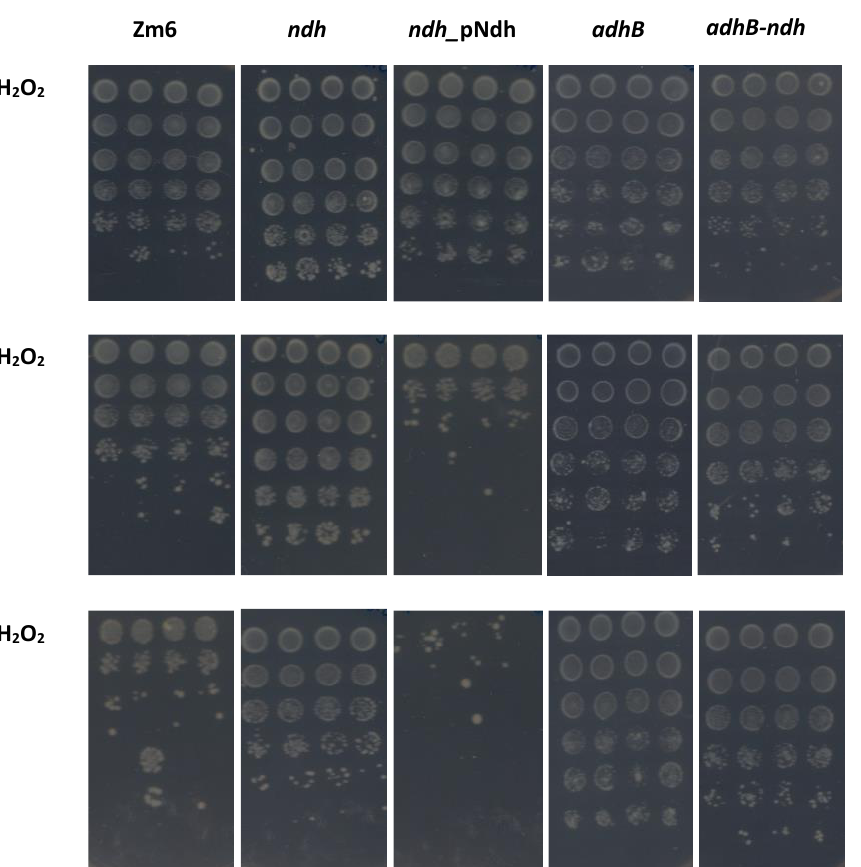
Figure 3. Viability of cells from exponential phase cultures after 30 min incubation with hydrogen peroxide. Serial dilutions ranging from OD 0.5 to 0.5 × 10 − 5 (from the top to bottom of each panel) were plated on agar plates in four replicates for each strain at each peroxide concentration.